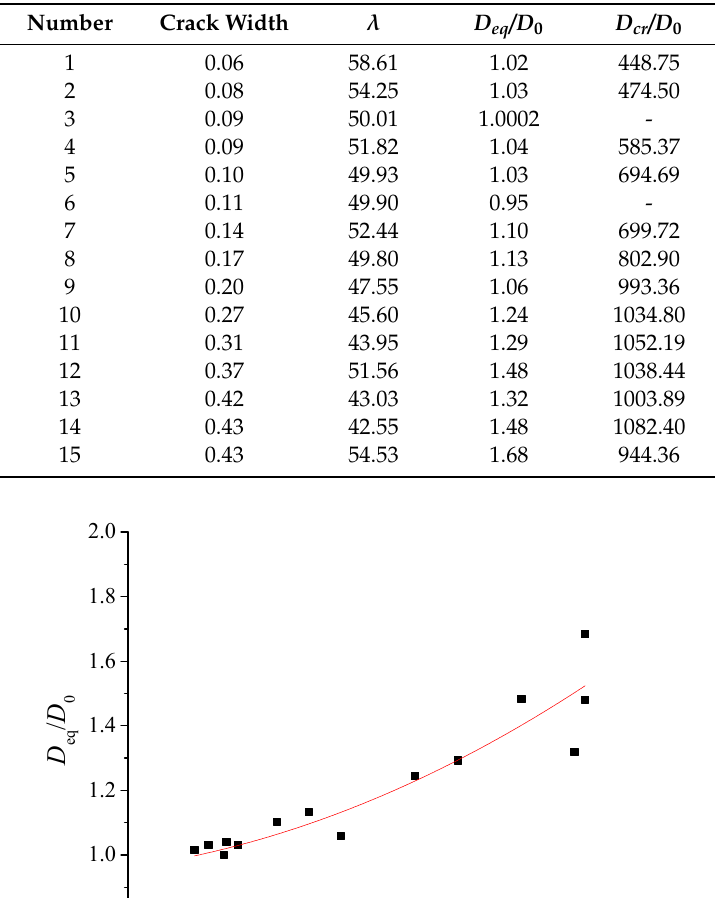
Table 3. Measured di ff usion coe ffi cients for various test variables.